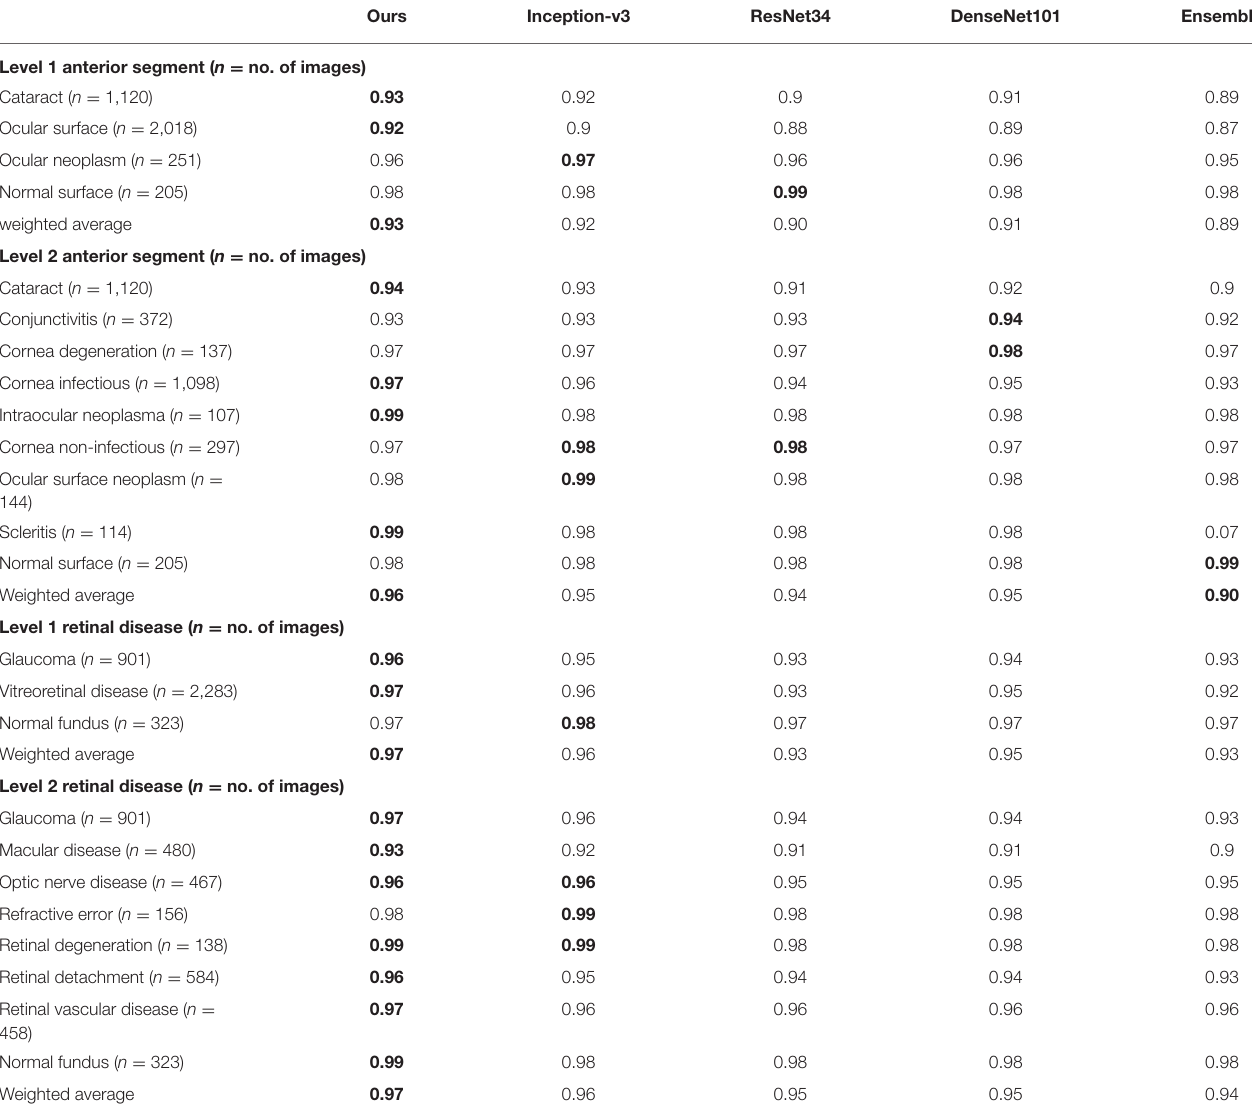
TABLE 3 | Accuracy comparison between the proposed hierarchical deep learning framework and existing deep learning frameworks. Ours Inception-v3 ResNet34 DenseNet101